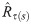
Selection for SARS (2003).Left graphs compare R^τ(s) estimates (blue with 95% confidence intervals) at optimal APE window length k* to weekly sliding windows (k = 7), which were recommended in [10]. Right graphs give corresponding one-step-ahead predictions x|Is-k+1s (blue with 95% prediction intervals). Dashed lines are the R = 1 threshold (left) and dots are the true incidence Is (right). Panel (A) directly uses the empirical SARS (2003) data [10] while (B) smooths outliers (with a 5-day moving average) in the data as in [16].